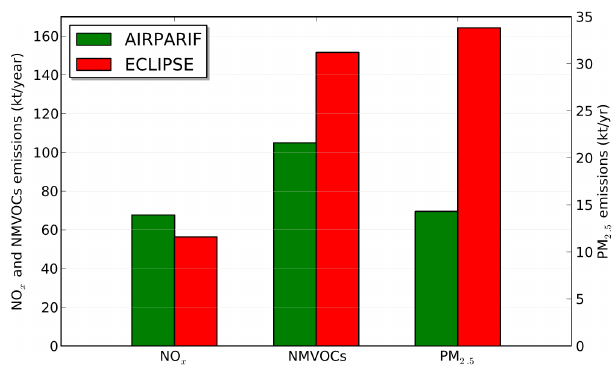
Figure 2. Domain-wide annual emissions of NO x , NMVOC (left- axis) and PM 2 . 5 (right-axis) from the local (bottom-up) and the re- gional (top down) inventory (summed across the vertical